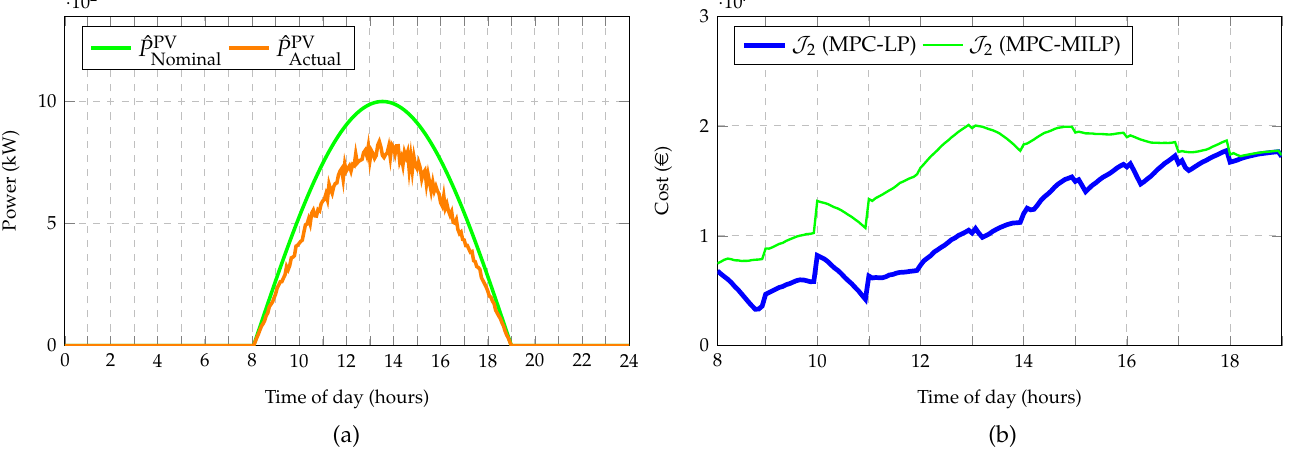
Figure 5. ( a ) Difference between the estimated power and the real power for a slightly cloudy day ( b ) Cost of MPC-LP and MPC-MILP algorithms. Under these conditions, the actual ˆ P PV is less than the model used in the t